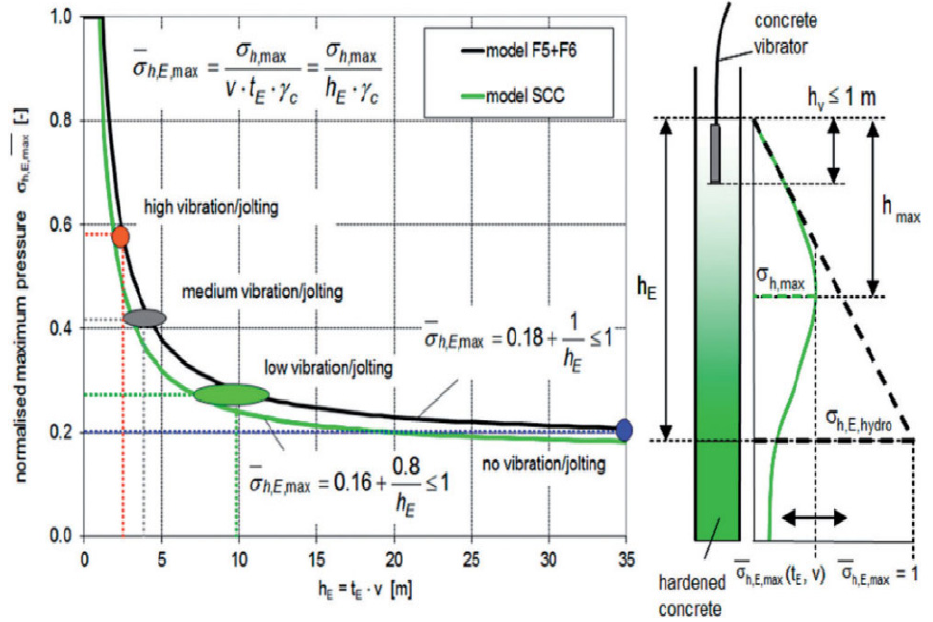
Figure 4. Normalized maximum pressure for high flowable concrete [42] (reprinted with permission from © John Wiley and Sons).